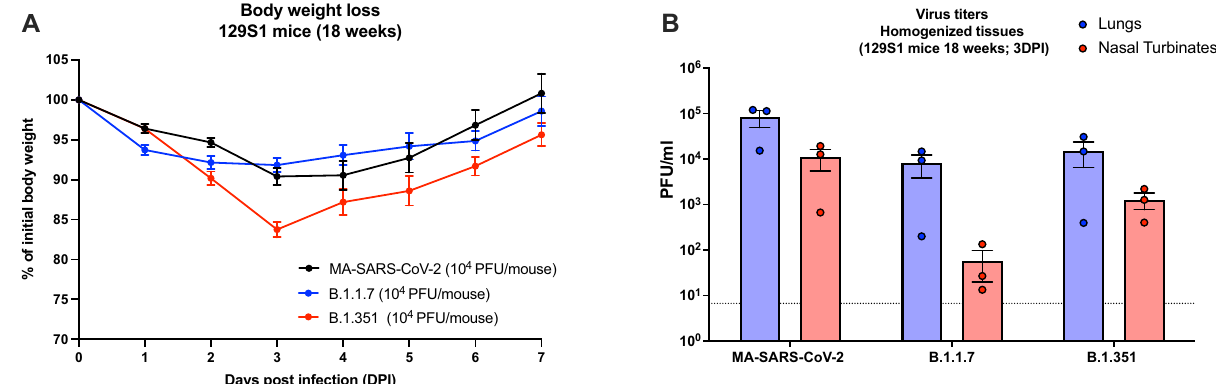
Fig. 5 Direct infection of 129S1 mice with VOCs that harbor the N501Y mutation. A 18-week-old 129S1 mice were infected with 10 4 PFU of MA-SARS- CoV-2, B.1.1.7, or B.1.351 ( n = 10/group). B Whole lungs and nasal turbinates were harvested from n = 3/group at 3 DPI for virus titration by plaque assay. Bars represent means; error bars represent SEM. Dotted line indicates limit of detection (LOD) = 66.67 PFU/ml. Source data are provided as a Source Data fi